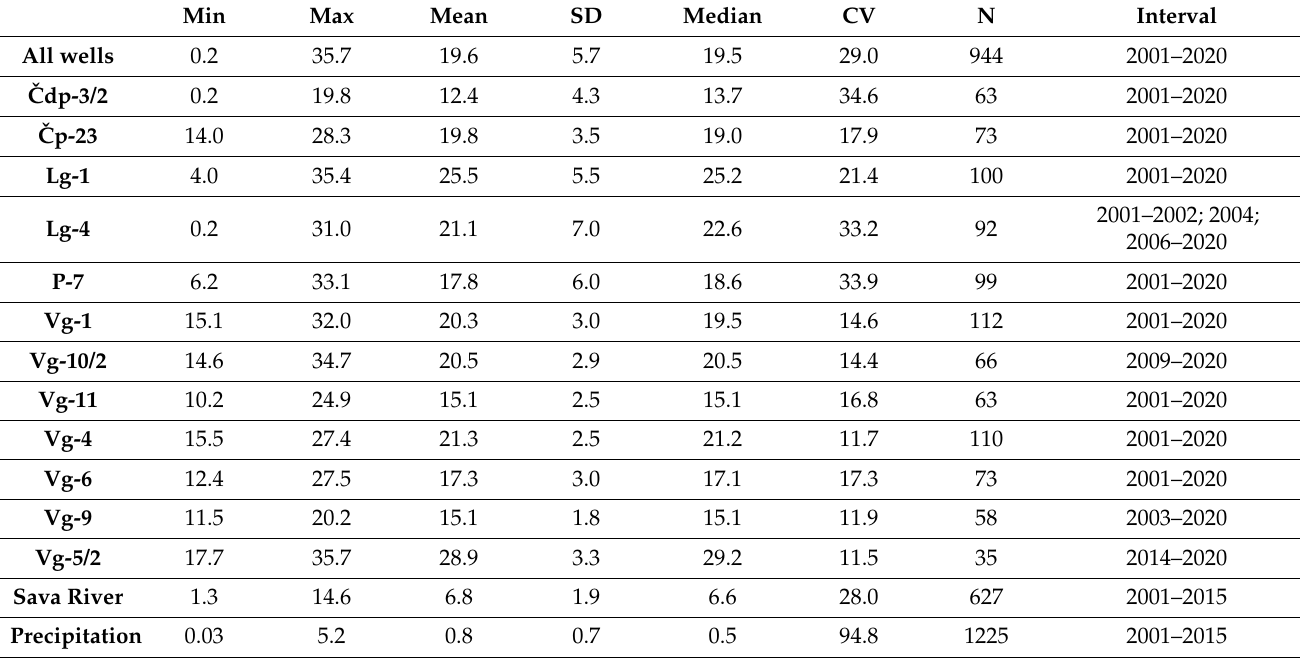
Table 1. Main statistics for nitrate in mg/L = milligram per liter as NO 3 . SD is standard deviation, CV is coefficient of variation in %, N is number of